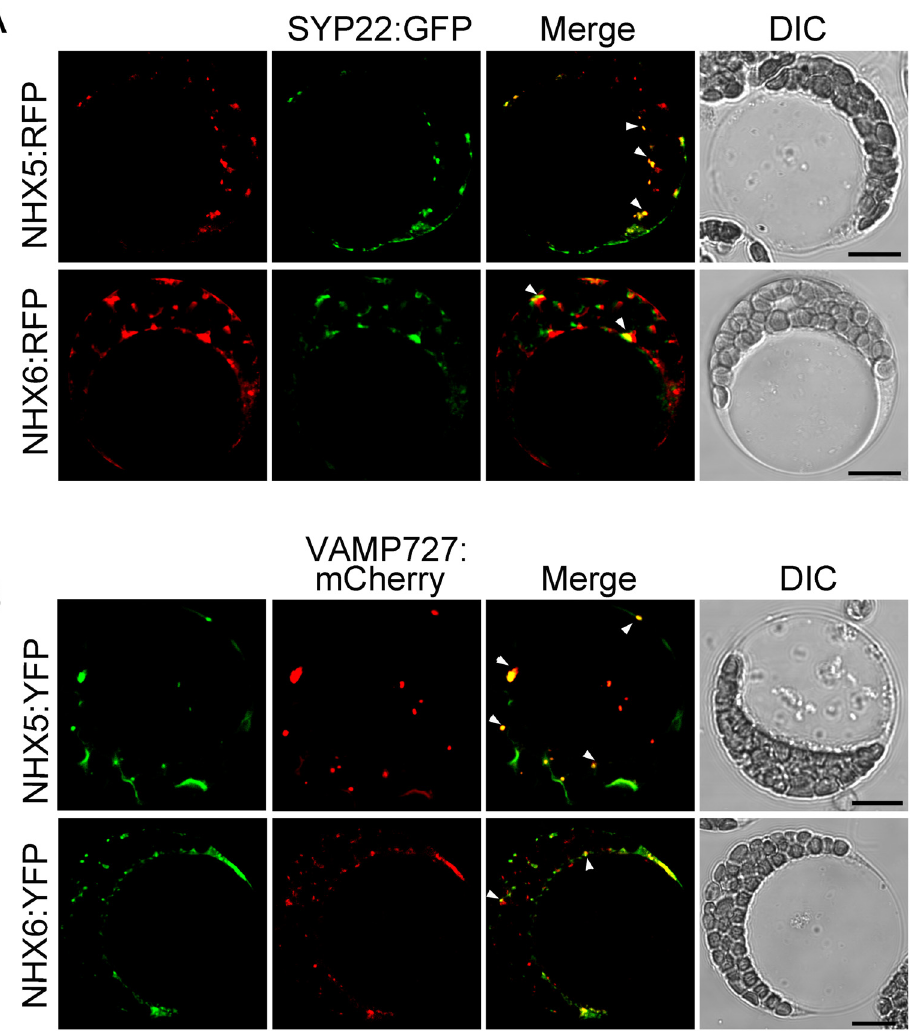
Fig 9. AtNHX5 and AtNHX6 are co-localized with SYP22 and VAMP727. (A) Subcellular localization of RFP:NHX5 or RFP:NHX6 with SYP22:GFP. The RFP : AtNHX5 or RFP : AtNHX6 plasmids were transiently co-expressed in Arabidopsis leaf protoplasts with SYP22:GFP, respectively. Fluorescence was visualized by a confocal laser scanning microscope. (B) Subcellular localization of YFP:NHX5 or YFP:NHX6 with VAMP727:mCherry. The YFP : AtNHX5 or YFP : AtNHX6 plasmids were transiently co-expressed in Arabidopsis leaf protoplasts with VAMP727:mCherry, respectively. Fluorescence was visualized by a confocal laser scanning microscope. Bar = 10 μ m in (A) and